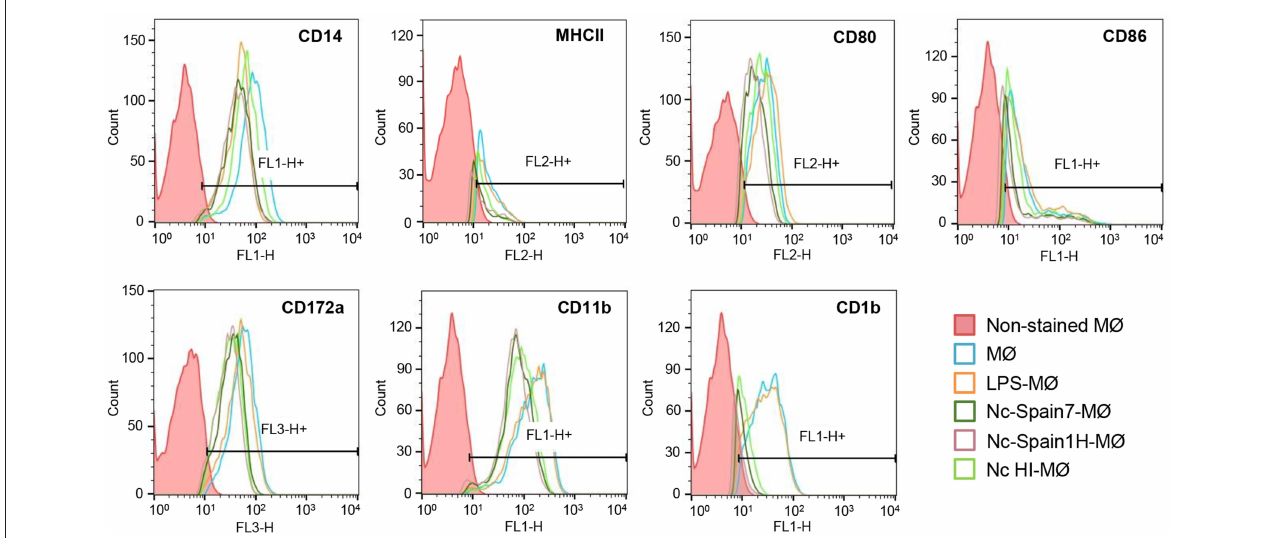
FIGURE 8 | Phenotypic characterization of bovine MØs inoculated with Nc-Spain7, Nc-Spain1H, and HI tachyzoites. Histograms represent the percentage of positive cells and mean fluorescence intensity (MFI) of CD14, MHC class II, CD80, CD86, CD172a, CD11b, and CD1b markers determined by flow cytometry in non-infected MØs (MØ) and MØs challenged for 4h with N. caninum Nc-Spain7 (Nc-Spain7-MØ), Nc-Spain1H (Nc-Spain1H-MØ), heat-inactivated tachyzoites (Nc HI-MØ), and stimulated with 100 ng ml − 1 LPS (LPS-MØ). Histograms are representative of three independent experiments.